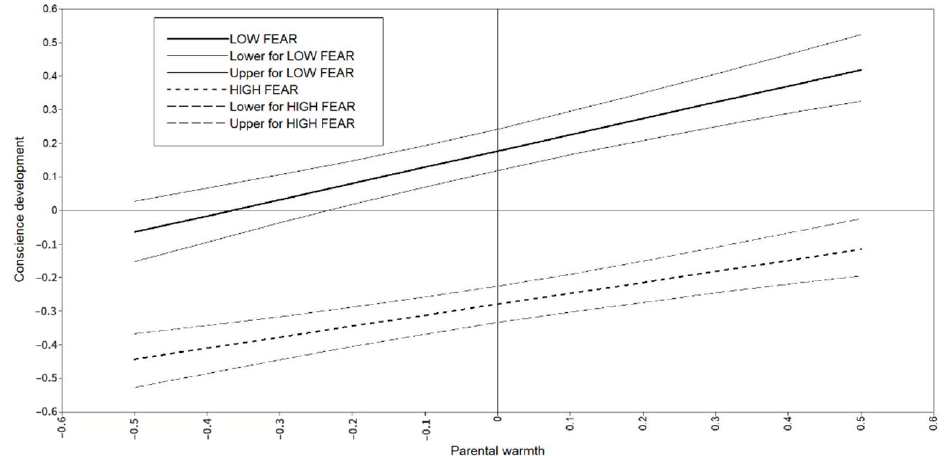
Figure 3. Estimated conscience development at T2 by the interaction of parental warmth and fearlessness at